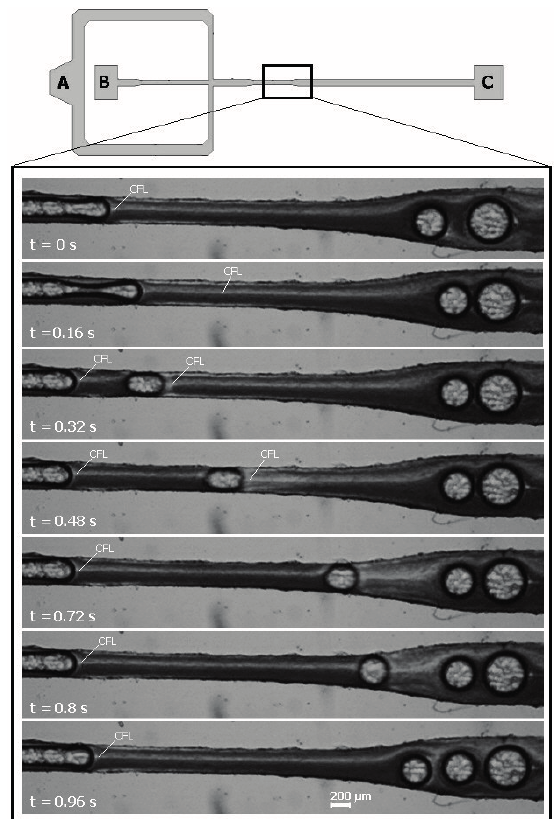
Figure 12. Visualization of bubbles generation and in vitro blood flow containing bubbles through a flow-focusing device fabricated by